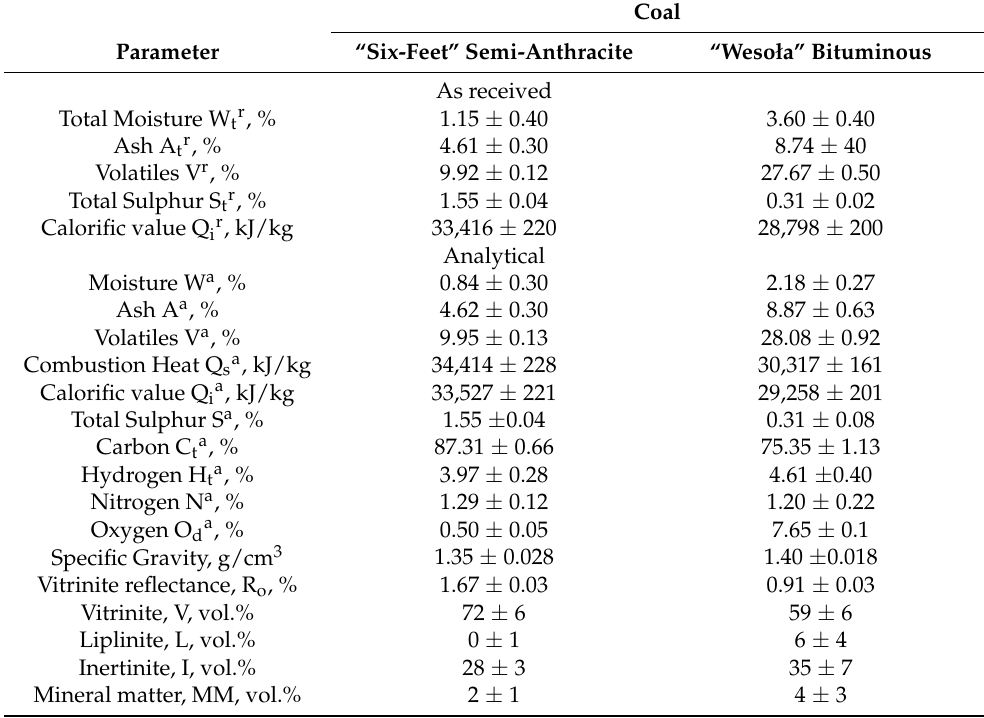
Table 1. Characteristics of coals used for the UCG experiments.